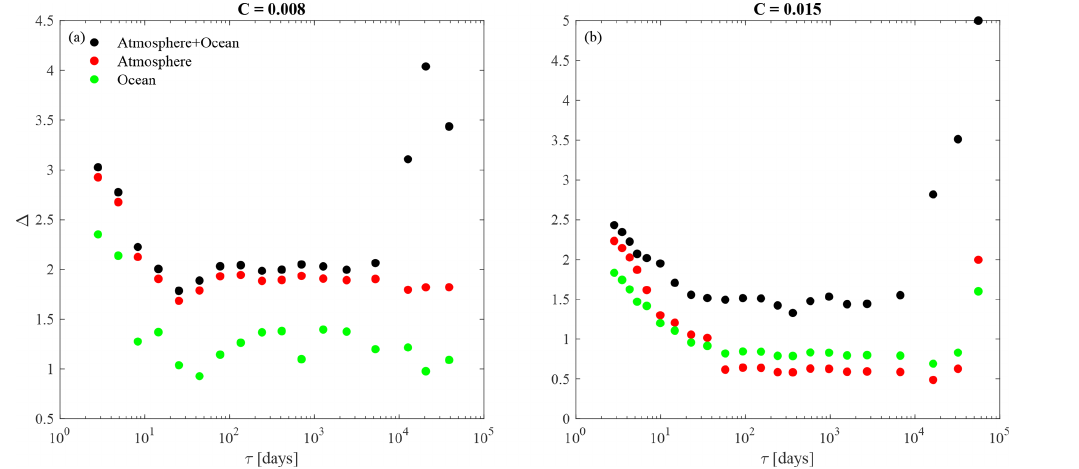
Figure 10. Multifractal width (cid:49) at different timescales τ j for reconstructions of MIMFs as in Eq. (12) ( D q,τ ) for (a) C = 0 . 008 and (b) C = 0 . 015. The different colors refer to the full system (atmosphere + ocean, black circles), only the atmosphere (red circles), and only the ocean (green circles),